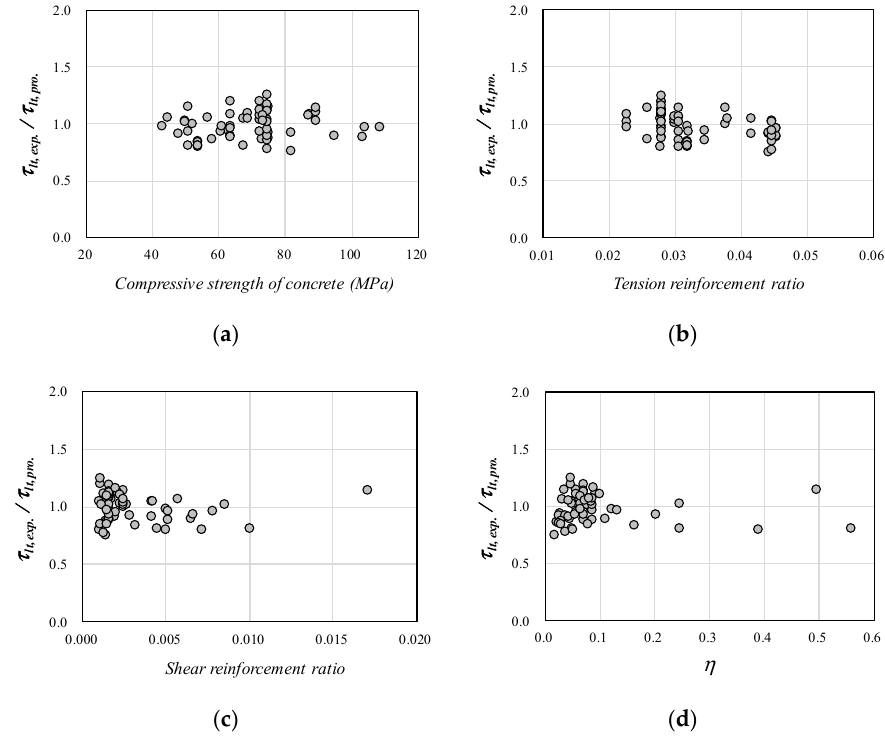
Figure 7. Prediction results of proposed model on test variables: ( a ) compressive strength of concrete; ( b ) tension reinforcement ratio; ( c ) shear reinforcement ratio; ( d ) η (= ρ t f ty / ρ l f ly )